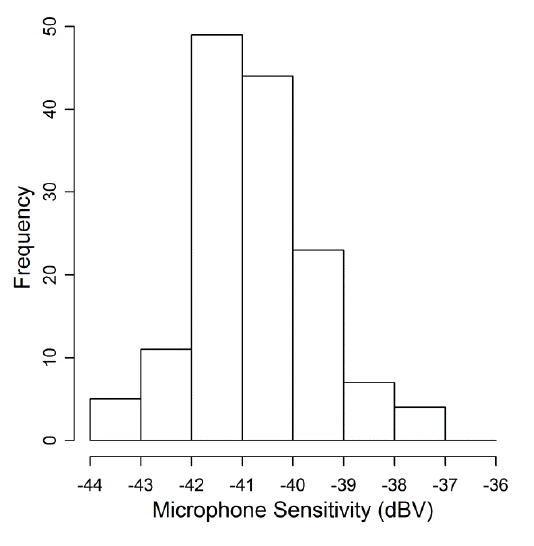
Fig. 4 . Box plot of measured microphone sensitivity (dBV) of three cohorts of SMX-II microphones representing microphones purchased in 2014 and never deployed (n = 143), microphones used for only one field season (n = 151), and microphones used for 2-4 consecutive field seasons (n = 75). The centerline of each box represents the median microphone sensitivities of -40.9, -41.9, -42.8 dBV, respectively. Boxes represent the data between 25th and 75th percentiles, and the whiskers represent 1.5 times the interquartile range. Outliers in each population are represented by dots. The solid and dotted horizontal lines depict the stated manufacturer specifications of mean sensitivity and expected variation of -36 dBV ±